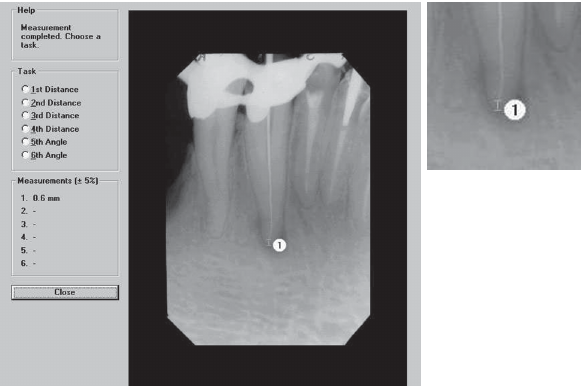
FIGURE 1 - Digora Mesuring Tool. (A) Delimiting reference points